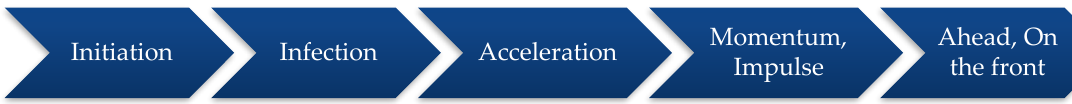
Figure 12. An organization’s analytics maturity at each of the five stages of analytics continuum. Source: own elaboration.